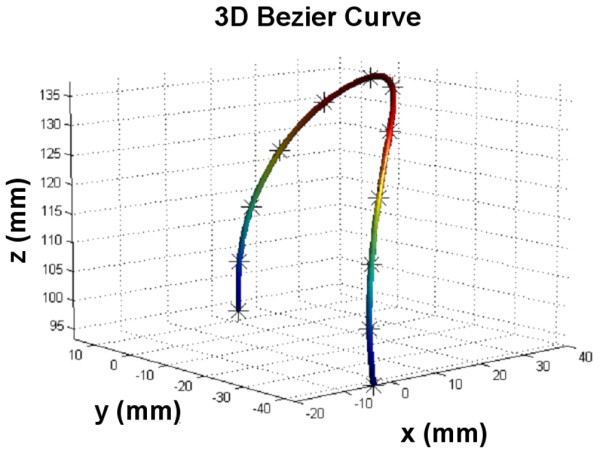
Estimation of the aortic length. Estimation of the aortic length from the axial and coronal slices with a 3D Bezier curve interpolation